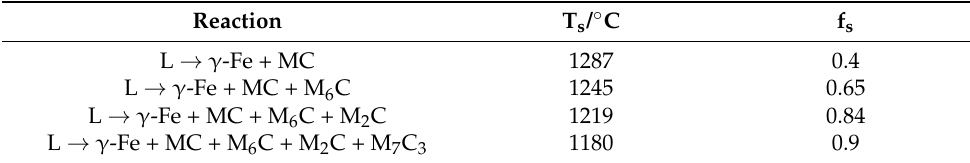
Figure 8. Non-equilibrium phase diagram in HSS. Table 4. Calculation results of non-equilibrium phase precipitation using Thermo-Calc. Reaction